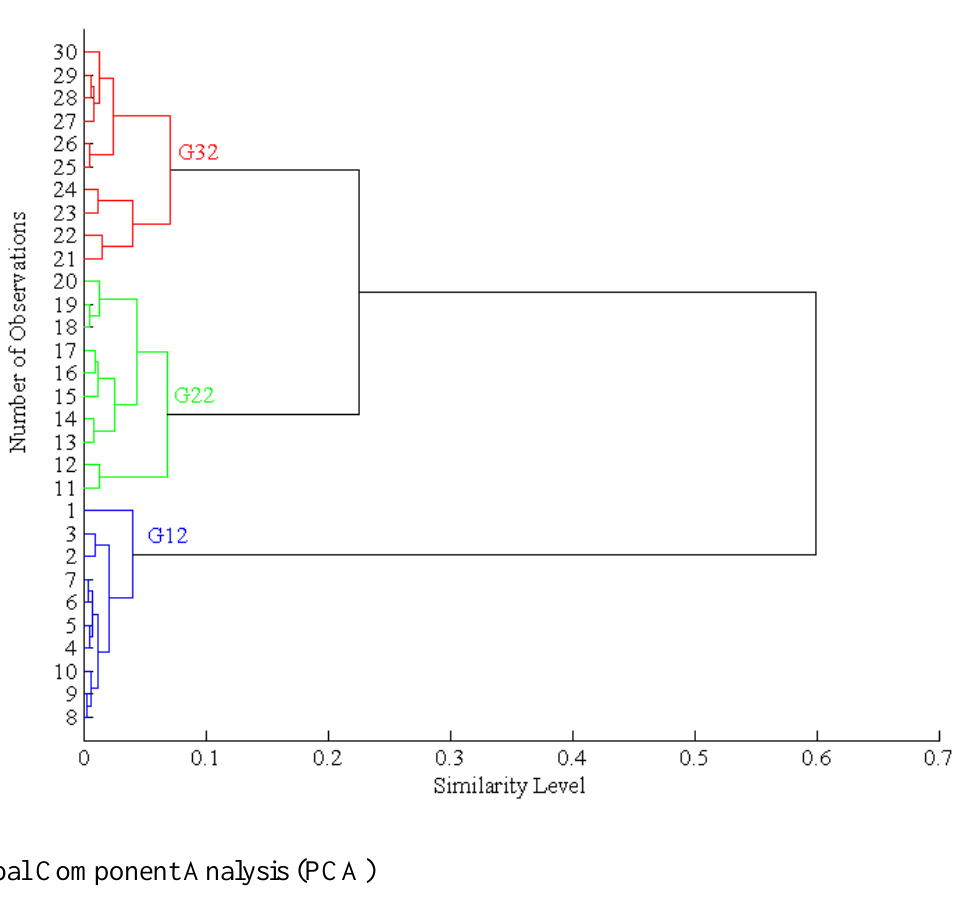
Figure 5. A dendrogram for the three-object data set from each 10 samples of G12, G22, and